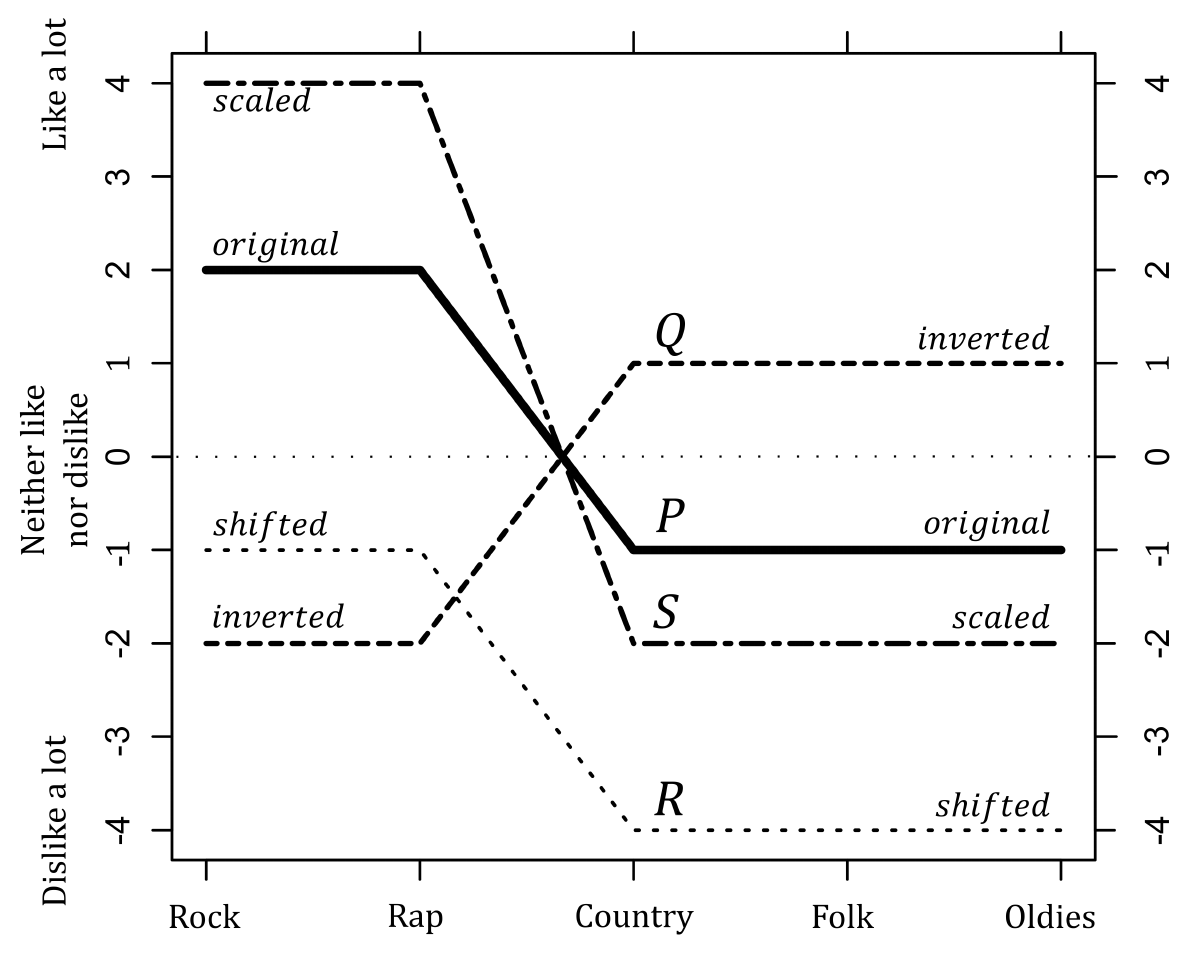
Figure 2: Original schema with the three basic linear schematic